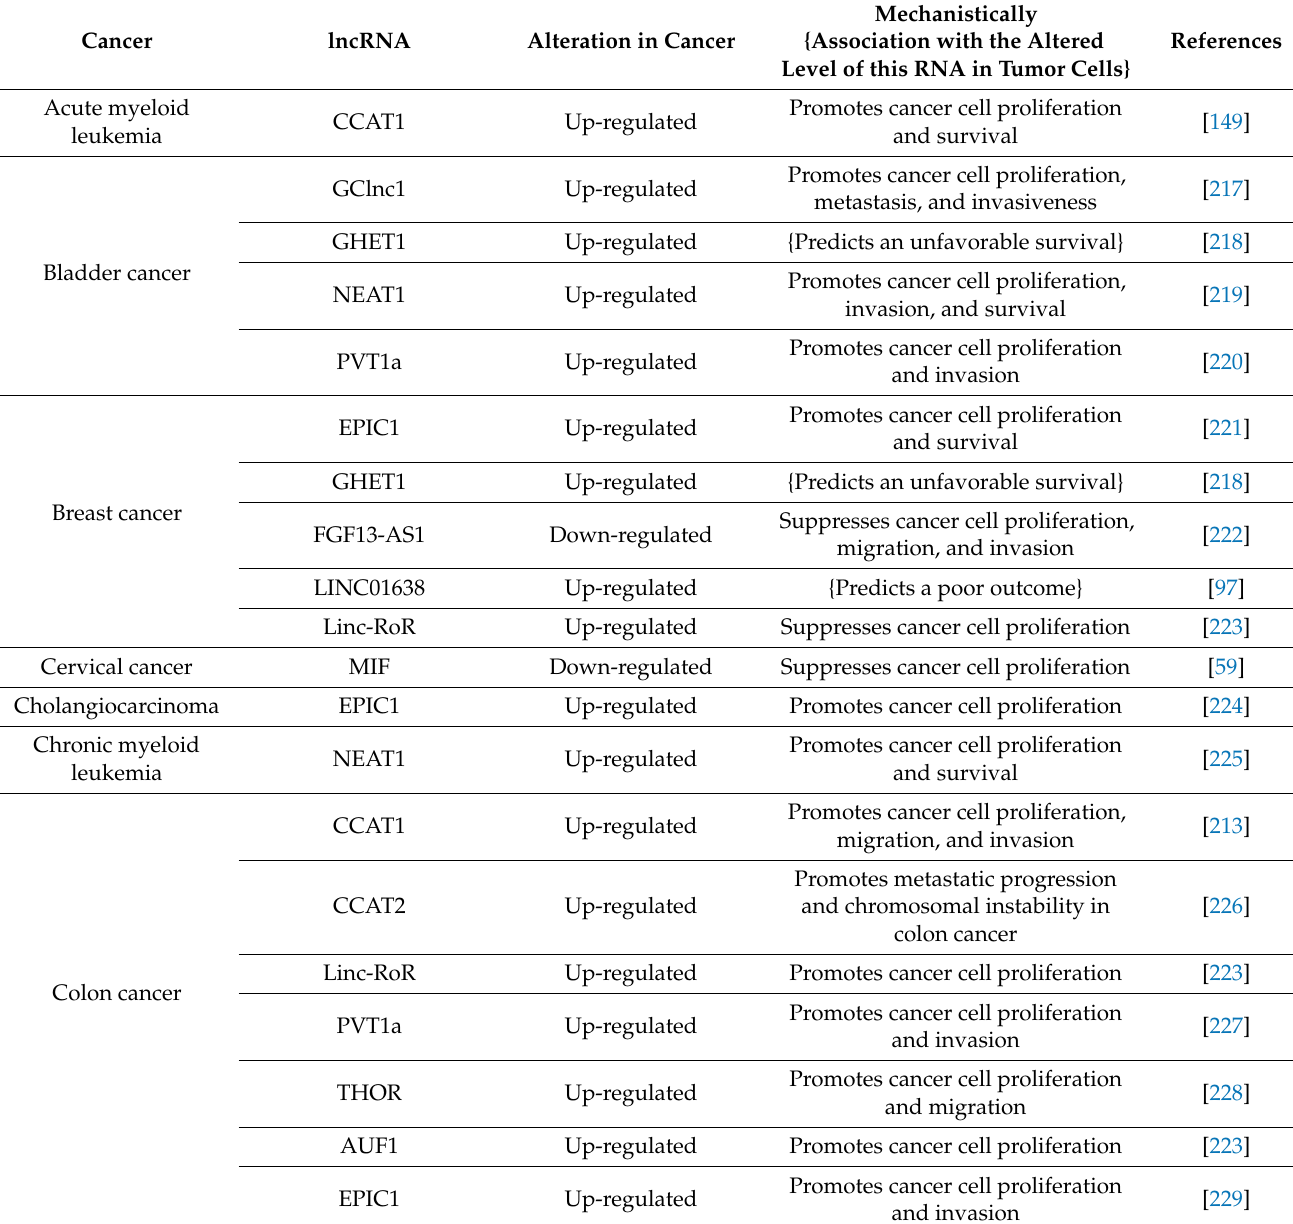
Table 2. lncRNAs that control the expression of the MYC gene in tumors of various human organs.